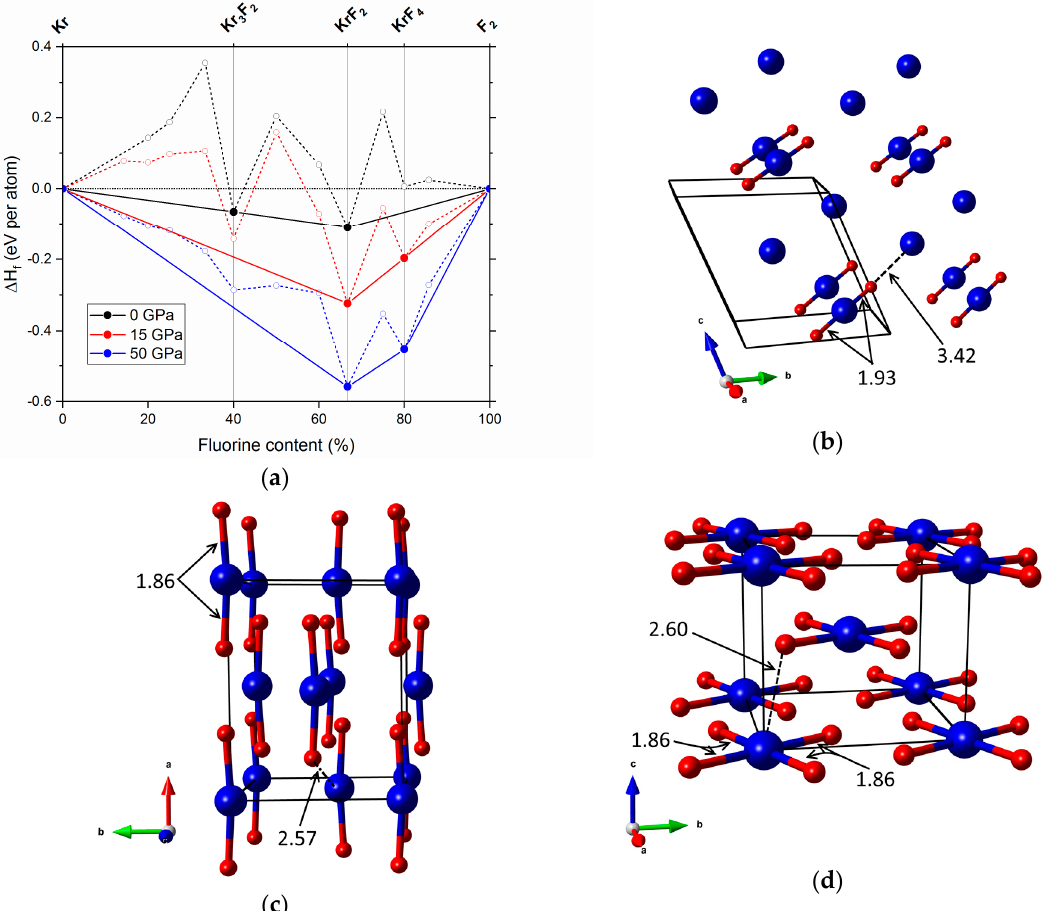
Figure 1. ( a ) Pressure dependence of the enthalpy of formation per atom of various Kr m F n phases at 0, 15 and 50 GPa. The compounds stable at 0 GPa (Kr 3 F 2 , KrF 3 ), 15 GPa (KrF 2 , KrF 4 ) and 50 GPa (KrF 2 , KrF 4 ) are marked in the upper part of the graph; ( b ) The P1 structure of Kr 3 F 2 (=2Kr·KrF 2 ) at 0 GPa; ( c ) The Cmcm structure of KrF 2 at 50 GPa; ( d ) the I4/m structure of KrF 4 at 50 GPa; blue/red balls depict Kr/F atoms; Kr–F bonds (solid lines) and shortest intermolecular Kr–F contacts (dashed lines) are given in Å.